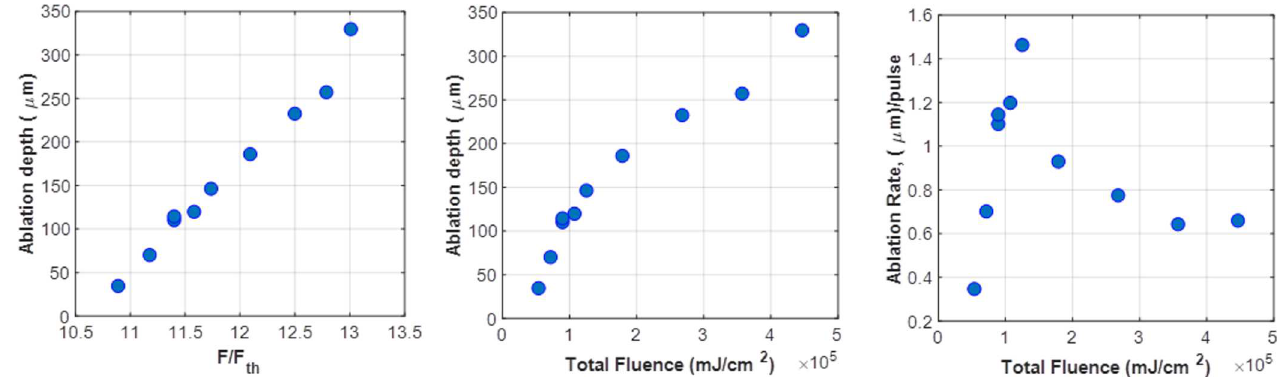
Fig 6. Total ablation depth as a function of (a) normalized fluence and (b) total fluence, and (c) variation in the ablation rate with the fluence.